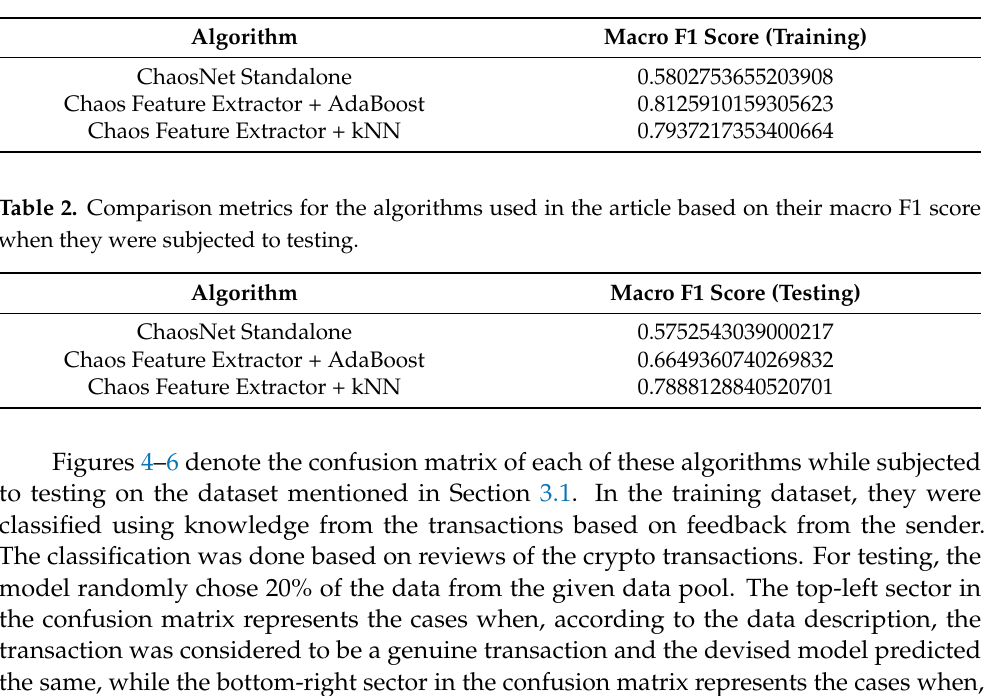
Table 1. Comparison metrics for the algorithms used in the article based on their macro F1 score when they were subjected to training.